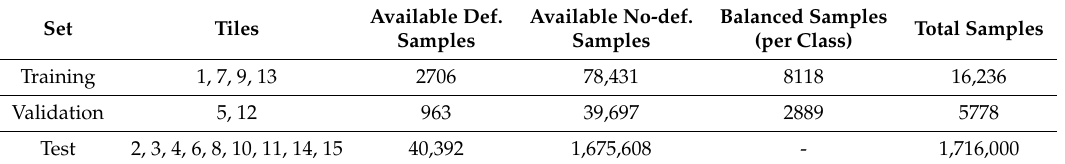
Table 1. Number of samples in the training, validation and test sets for Amazon